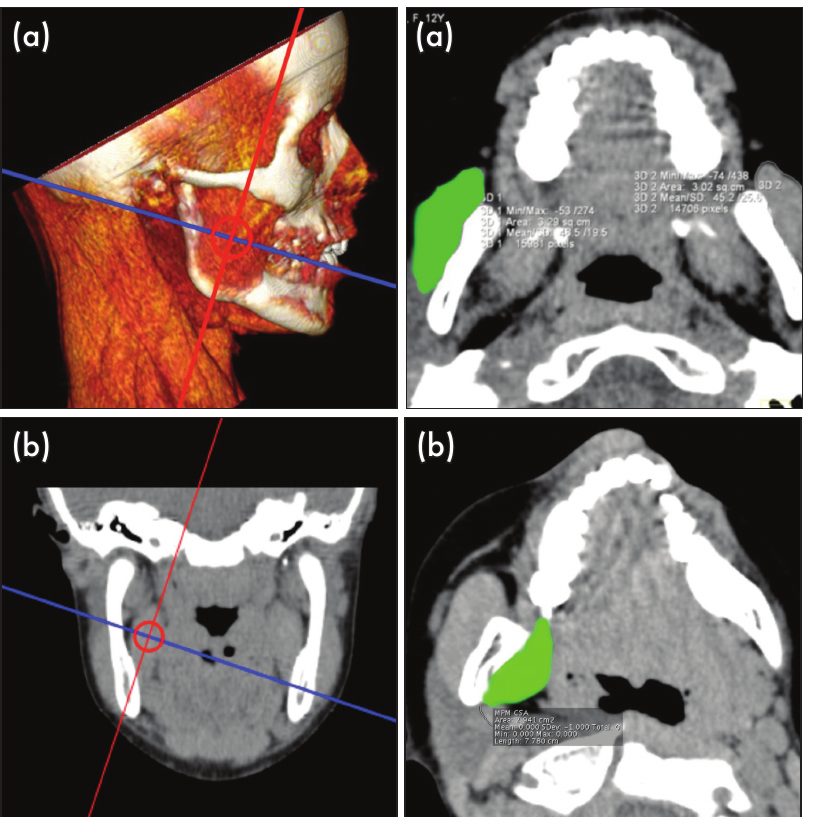
Figure 3. Multiplanar reconstructed (MPR) CT images generated for the analysis of the cross-sectional areas of the masseter and medial pterygoid muscles: (a) masseter, mid belly level; (b) medial pterygoid, mandibular foramen